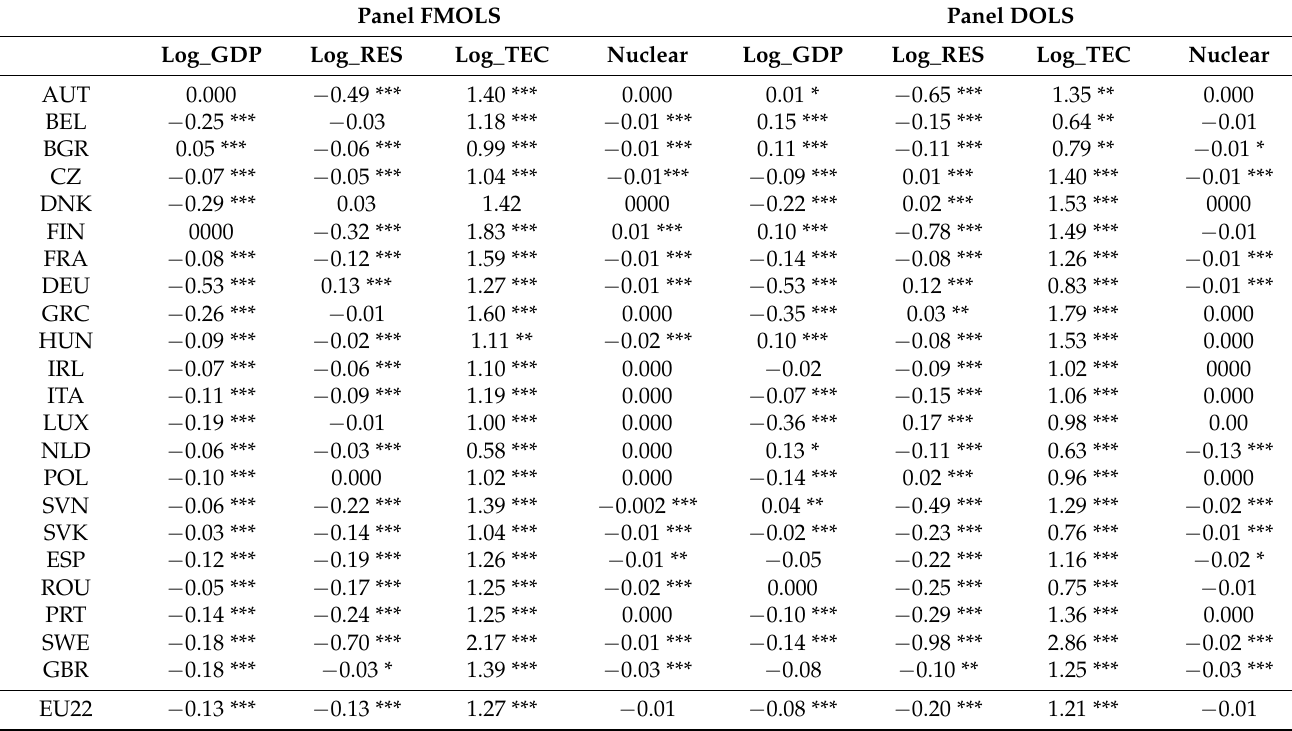
Table 4. FMOLS and DOLS estimation results in the long run (by